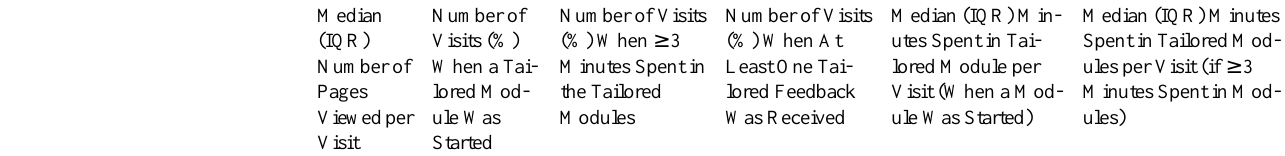
Table 2. Adherence at first visit according to time periods during open access use 2003-2009, and at first and longest visit according to open access context and randomized controlled trial